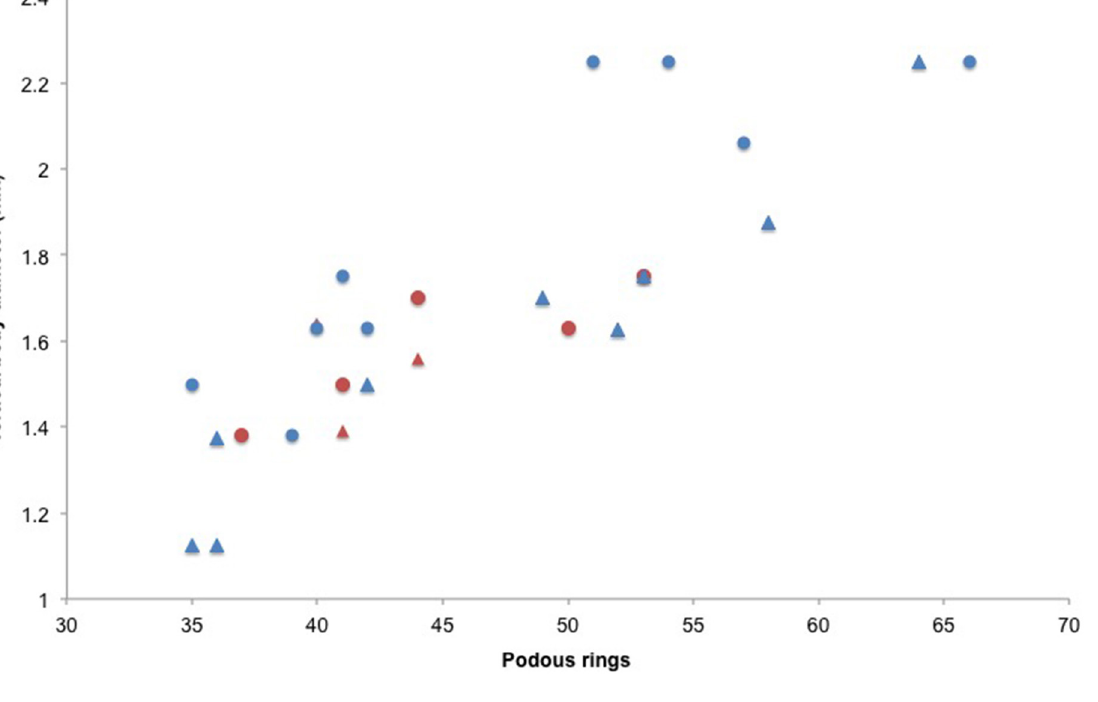
Fig. 8. Number of podous rings and midbody vertical diameter of the studied specimens. Chiraziulus kaiseri (Mauriès, 1983) in blue; Chiraziulus troglopersicus sp. nov. in red. ▲ = adult ♂♂; ● = juveniles and